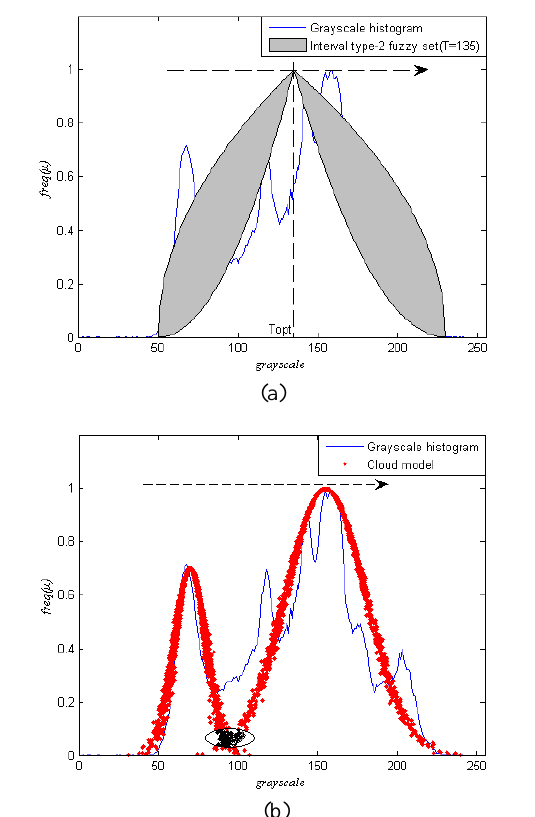
Fig. 4. Comparison on the optimal thresholding